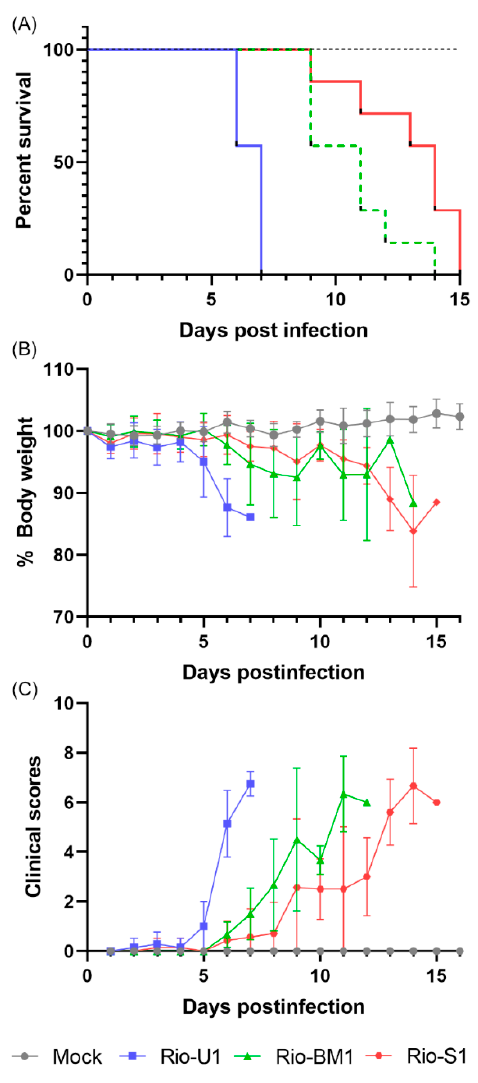
Figure 7. Infection of AG129 mice by the ZIKV isolates Rio-U1, Rio-BM1 e Rio-S1. Mice were infected with 10,000 PFU in both hind footpads with the different viral isolates or with diluent medium (Mock). We followed up with the mice daily for two weeks. ( A ) Deaths were recorded in Kaplan–Meier survival curves, and morbidity among these animals was also determined by ( B ) weight loss and ( C ) clinical scores. Error bars represent the SD of the mean for each group of mice. (The blue color represents the Rio-U1 virus, the green Rio-BM1 and the red Rio-S1 virus). We also determined viremia at days two, four, six, and eight post-inoculations of the ZIKV isolates (Figure 8A) as well as at the time of death (euthanasia) (Figure 8B). Animals infected with Rio-U1 had higher viral loads at all times points analyzed, with the peak viral load of 1.9 × 10 8 viral copies/mL at day four post-inoculation. Animals infected with the viruses Rio-BM1 and Rio-S1 showed a delayed peak viremia on the sixth day after infection with viral loads of 1.2 × 10 8 and 1.1 × 10 8 viral copies/mL, respectively. Statistical